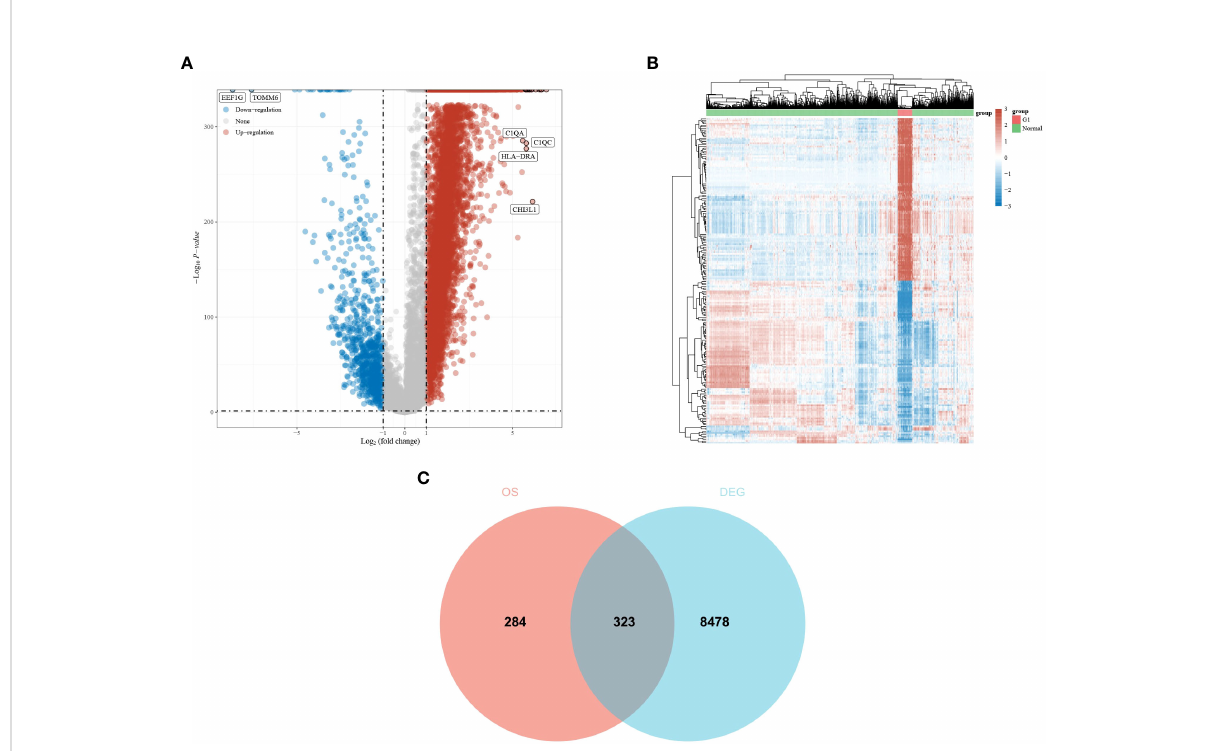
FIGURE 1 Differential expression analysis of glioma dataset to obtain DEGs. (A, B) Differential expression analysis volcano and heat map. The volcano plot in red indicates up-regulated genes, and that in blue indicates down-regulated genes. (C) An intersection of prognostic genes obtained from whole-gene batch survival with DEGs was taken. Red indicates prognostic genes, and blue indicates